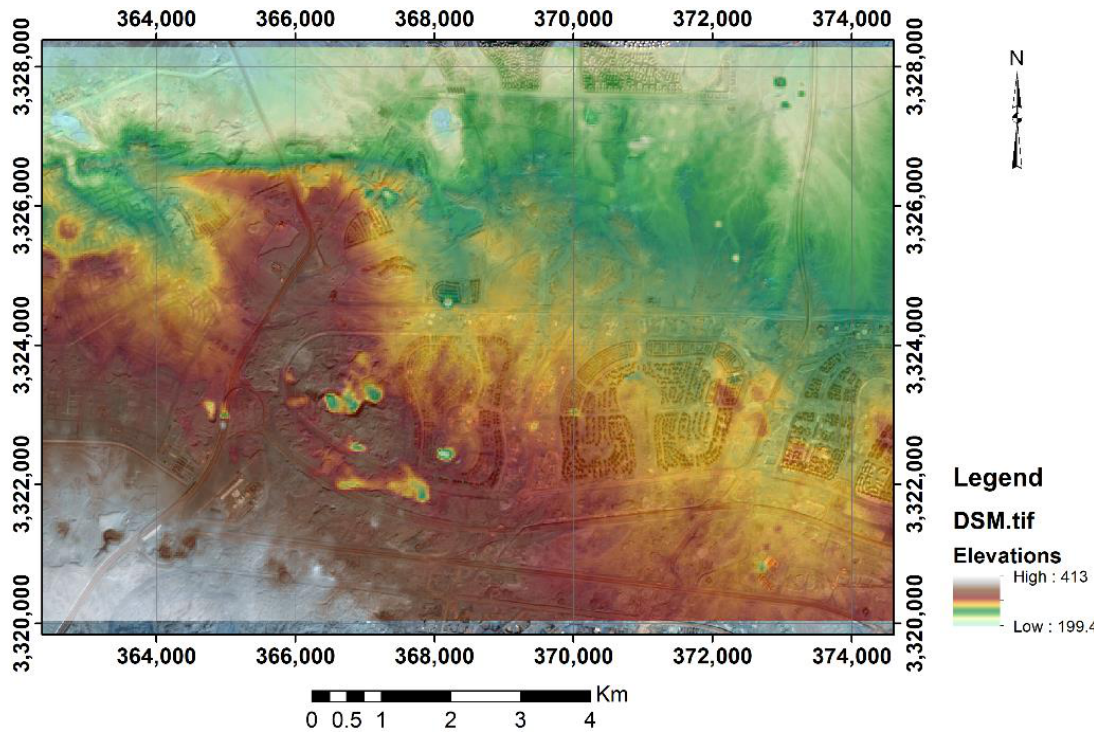
Figure 3. DSM of study area projected by WGS84/UTM coordinate system.